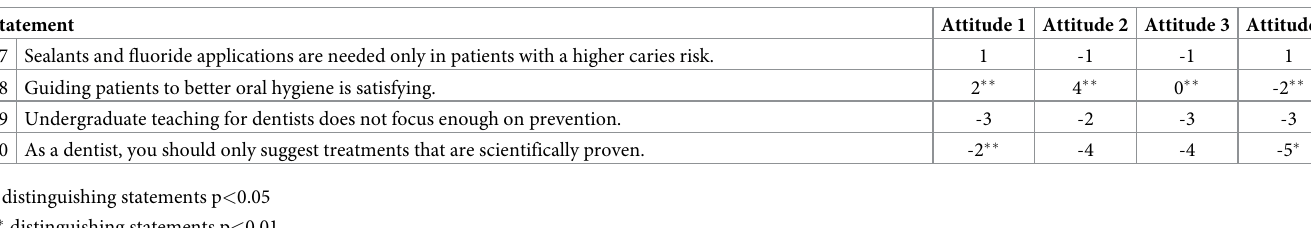
PLOS ONE | https://doi.org/10.1371/journal.pone.0219931 August 20,